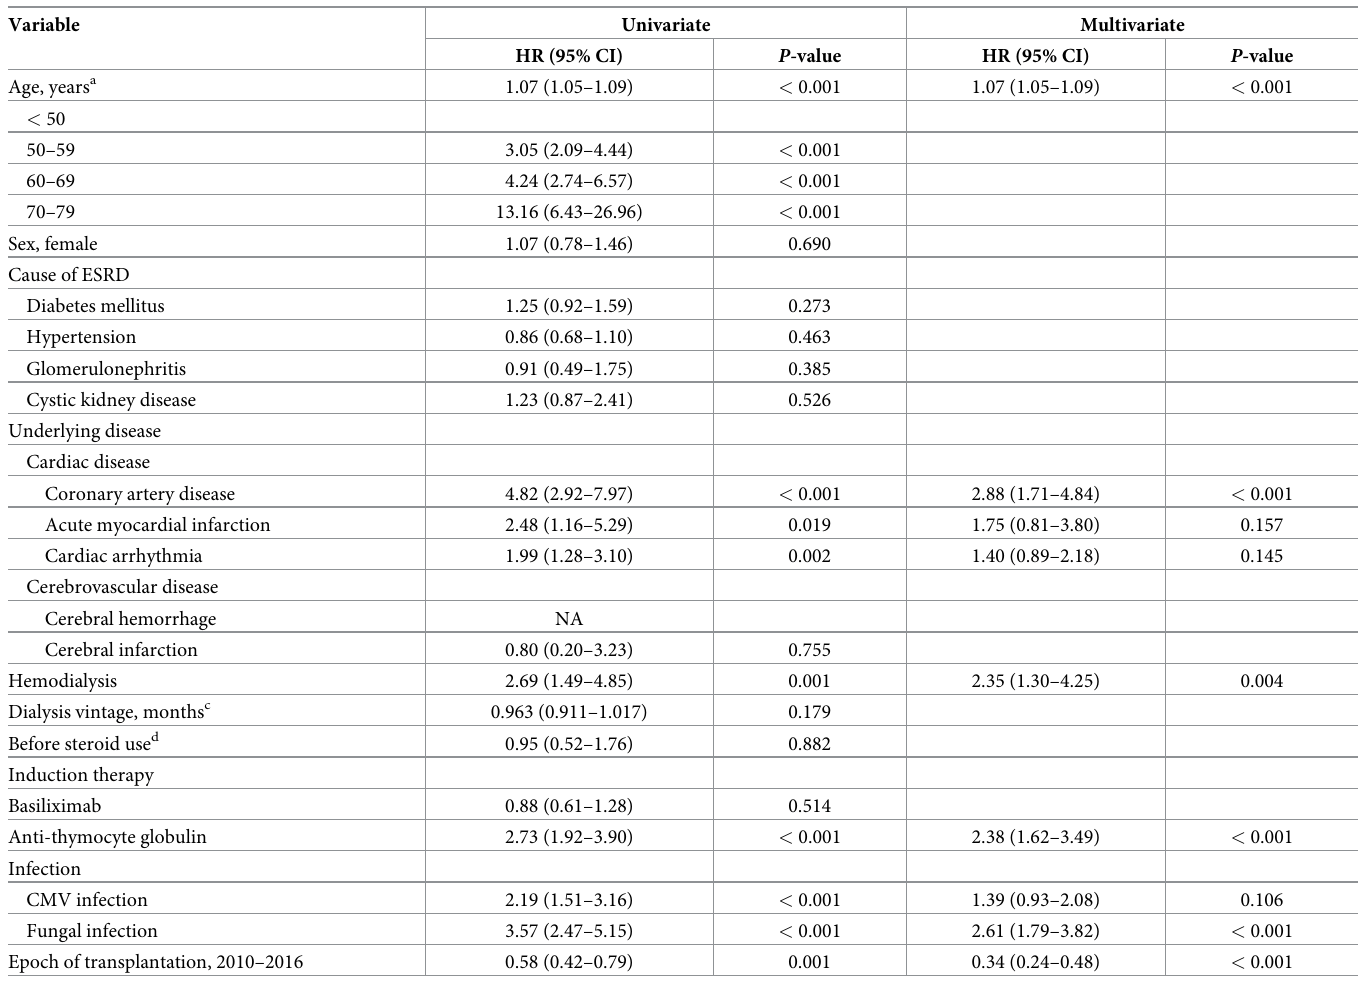
Table 3. Univariate and multivariate analyses of 3-month mortality after kidney